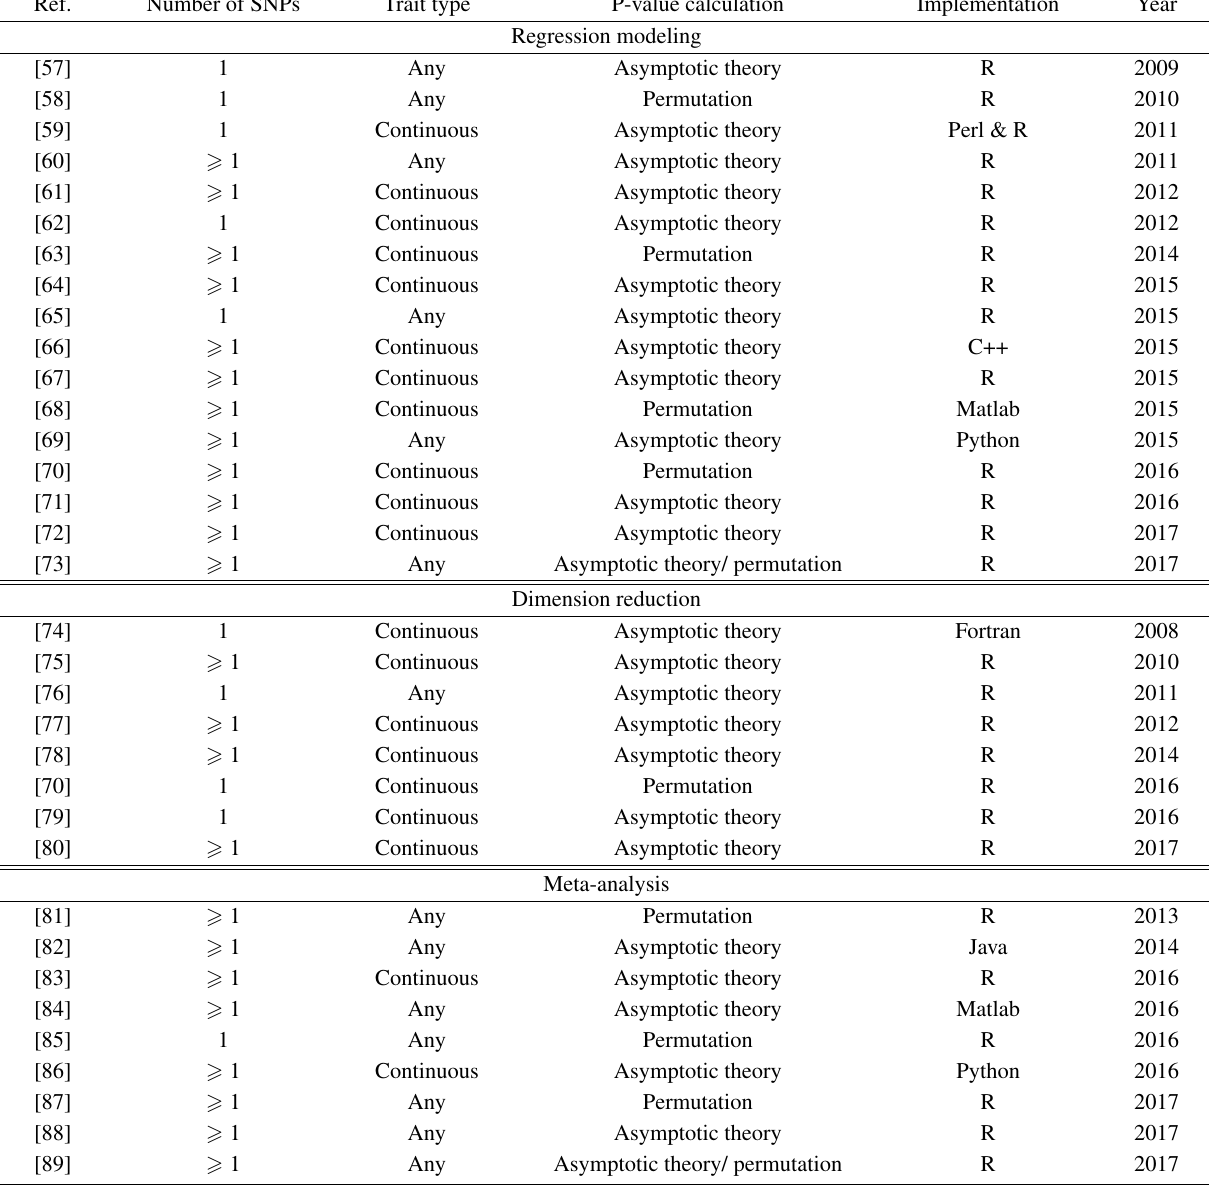
Table 4 Methods used in cross-phenotype association analyses.